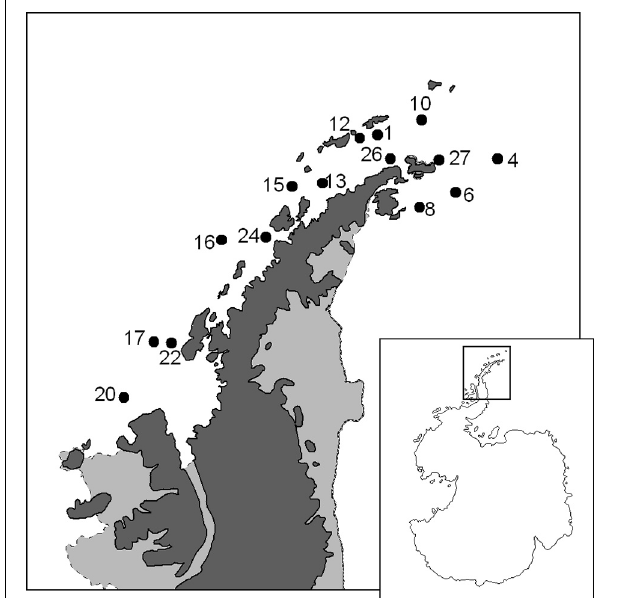
FIGURE 1 | Map of the area sampled during the ATOS-Antarctic cruise with the position of the studied stations.